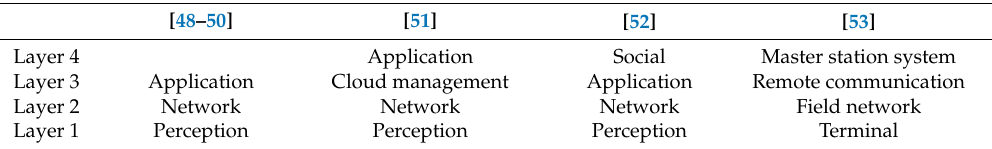
Table 1. Three-layer and four-layer models which are proposed for IoT architecture in a smart